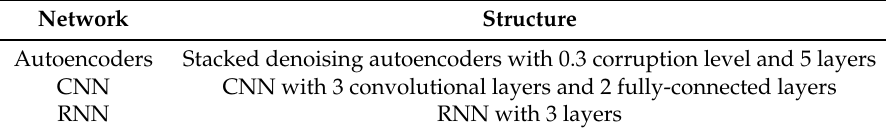
Table 1. The structures of different networks implemented by the proposed